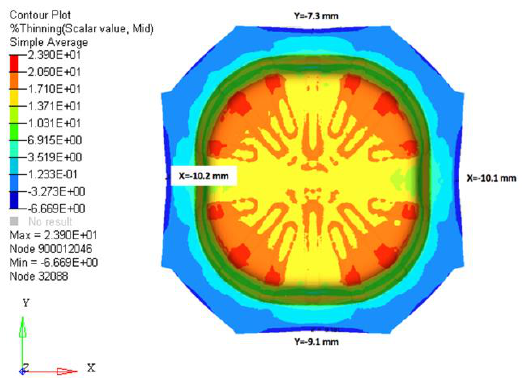
Figure 30. %Thinning distribution and X1, X2, Y1 and Y2 for optimal combination for blank0.